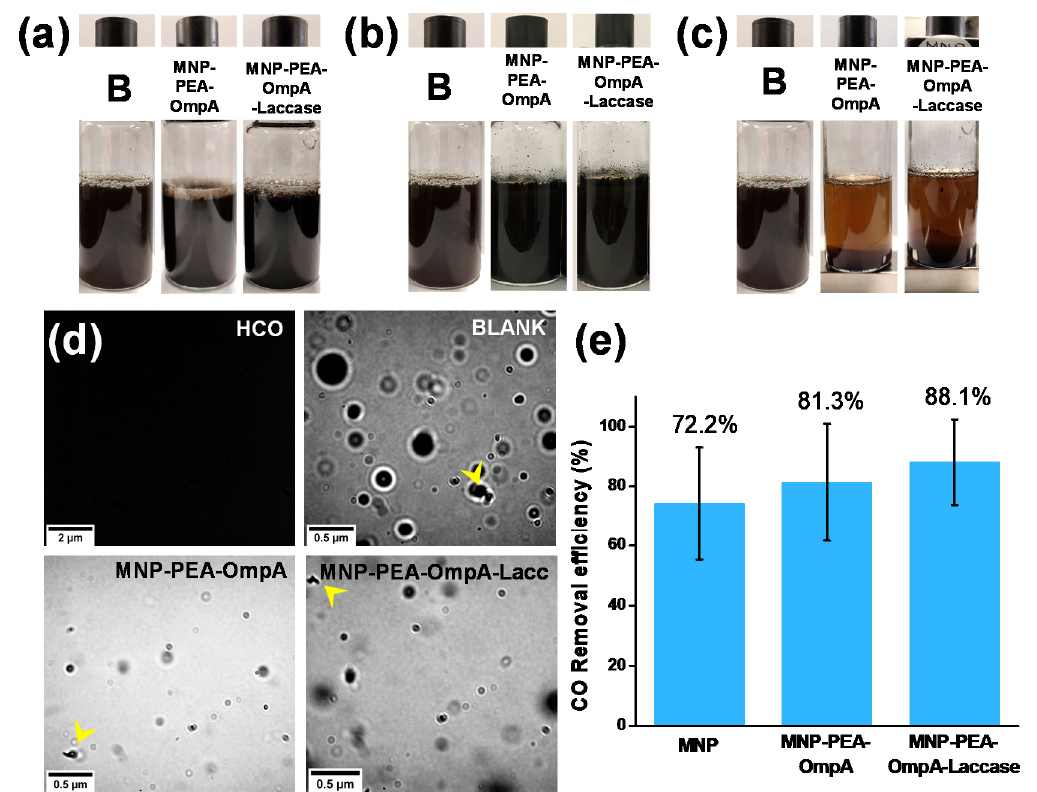
Figure 5. Demulsification assay of O / W emulsions by MNP-PEA-OmpA and MNP-PEA-OmpA-Laccase at 5000 ppm. Blank of O/W emulsion (B) and samples with MNP-PEA-OmpA and MNP-PEA- OmpA-Laccase ( a ) after preparation and initial exposure to treatments, ( b ) after 1 h of exposure, and ( c ) after 1 h of exposure and the application of an external magnetic field for MNP-PEA-OmpA and MNP-PREA-OmpA-Laccase bionanocompounds. ( d ) Optical microscopy images of emulsions before and after exposure to MNP-PEA-OmpA and MNP-PEA-OmpA-Laccase. ( e ) HCO removal efficiency percentage for MNP, MNP-PEA-OmpA, and MNP-PEA-OmpA-Laccase.